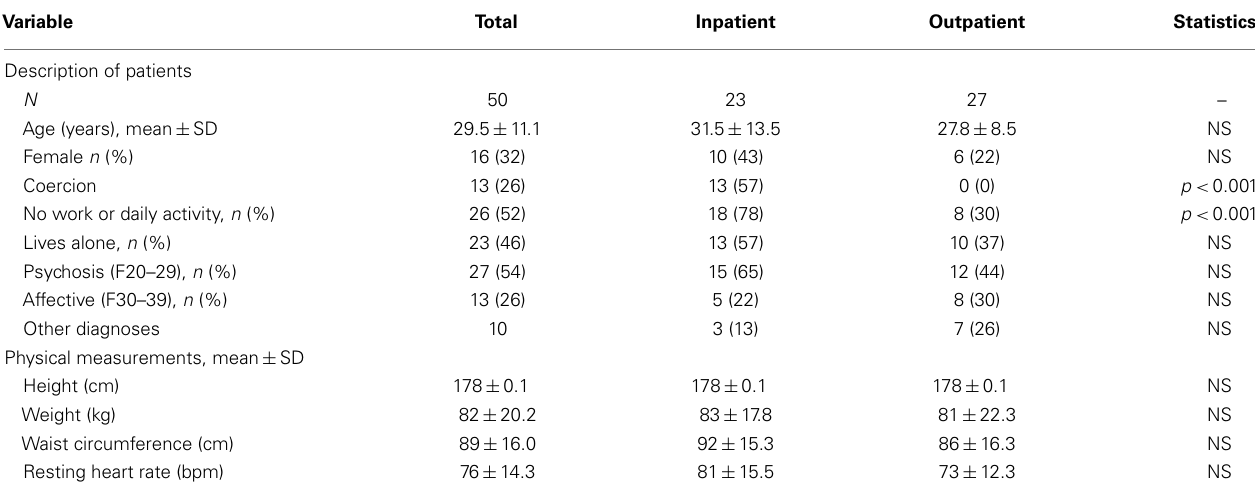
Table 1 | Description of the study population .